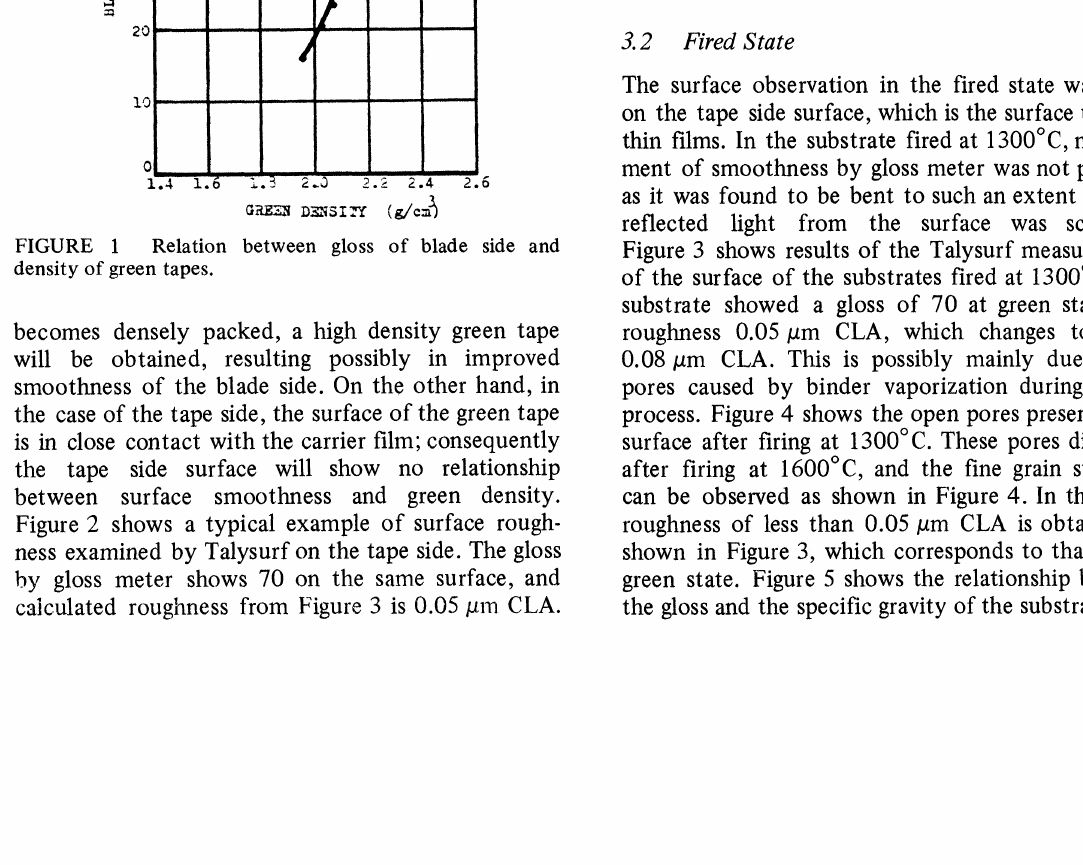
FIGURE 3 Surface roughness examined by Talysurf, 3(a) Fired at 1300C, 2 hours in air; tape side, 3(b) Fired at 1600 C, 2 hours in hydrogen; tape